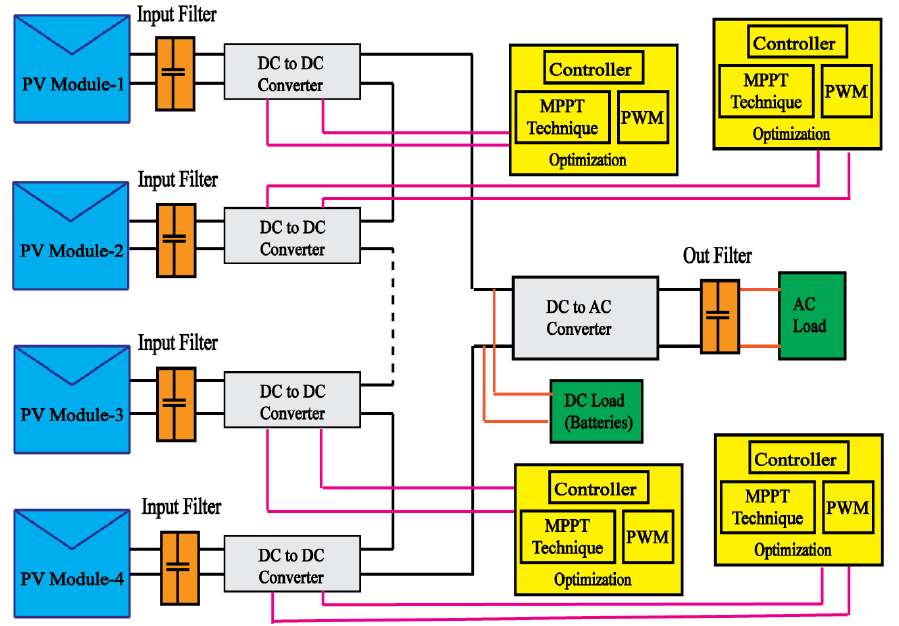
Figure 2. MLPE Distributed PV